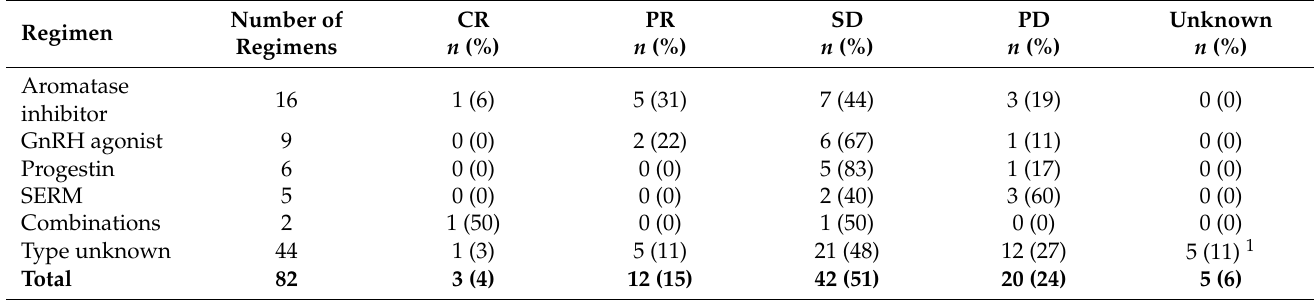
Table 5. Summary of response rates of anti-hormonal therapy for aGCT.